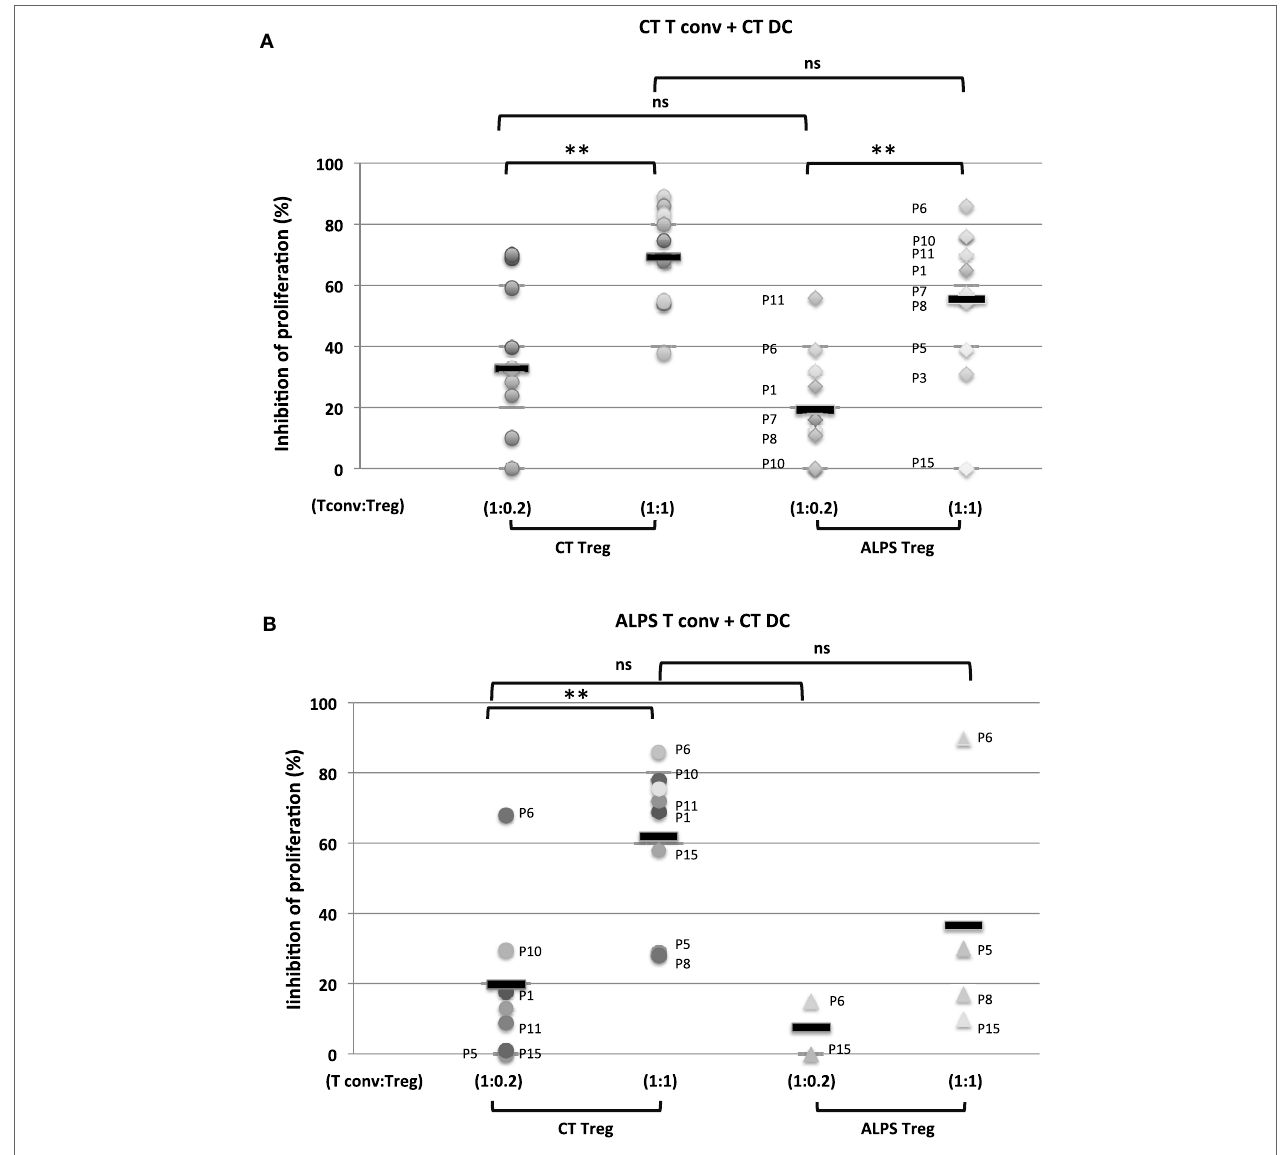
FigUre 6 | Functional characteristics of regulatory T cells (Tregs) and conventional effector T cell (Tconvs) from autoimmune lymphoproliferative syndrome (ALPS) patients. The figure shows the results of an in vitro suppression assay using total Tregs isolated from healthy controls (CTs) (CT Treg) and ALPS patients (ALPS Treg) with a Tconv:Treg ratio of 1:1 or 1:0.2 and carboxyfluorescein succinimidyl ester (CFSE)-stained naïve Tconvs from CTs [CT Tconv: in (a) ] or ALPS patients [ALPS Tconv, in (b) ]. The assays were performed with staphylococcal enterotoxin E (SEE) and dendritic cells (DCs) from CTs (CT DC) for 5 days. The results are expressed in percentage of inhibition of proliferating cells. Statistical analyses were performed using a non-parametric T -test (*** p < 0.001, ** p < 0.005, * p < 0.05, ns: not significant). The error bars correspond to the mean ± SD for duplicates. Panel (a) shows the mean (range) percentage of inhibition of CT Tconv proliferation by the CT Tregs (69.4 ± 16.4%) (38–89%) for a Tconv:CT Treg ratio of 1:1 ( n = 10); 32.8 ± 21.6 (0–69%) for a CT Tconv:CT Treg ratio of 1:0.2 ( n = 10) and by the ALPS Tregs [55.5 ± 26% (0–86%)] for a CT Tconv:ALPS Treg ratio of 1:1 ( n = 10); 19.4 ± 18.8 (0–56%) for a CT Tconv:ALPS Treg ratio of 1:0.2 ( n = 10). Panel (b) shows the mean (range) percentage of inhibition of ALPS Tconv proliferation by CT Tregs [61.6 ± 21% (28–86%)] for a ALPS Tconv:CT Treg ratio of 1:1 ( n = 9): 21.6 ± 22% (0–69%) for a ALPS Tconv:CT Treg ratio of 1:0.2 ( n = 8) or by ALPS Tregs (36.7 ± 36%) (10–90%) for an ALPS Tconv:ALPS Treg ratio of 1:1 ( n = 4); 7.4 ± 10.6 (0–15%) for an ALPS Tconv:ALPS Treg ratio of 1:0.2 ( n =